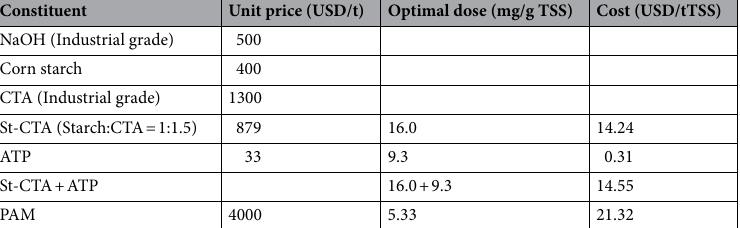
Table 2. Cost estimation of various flocculants/skeleton builder and their combinations including the cost of synthesis process.